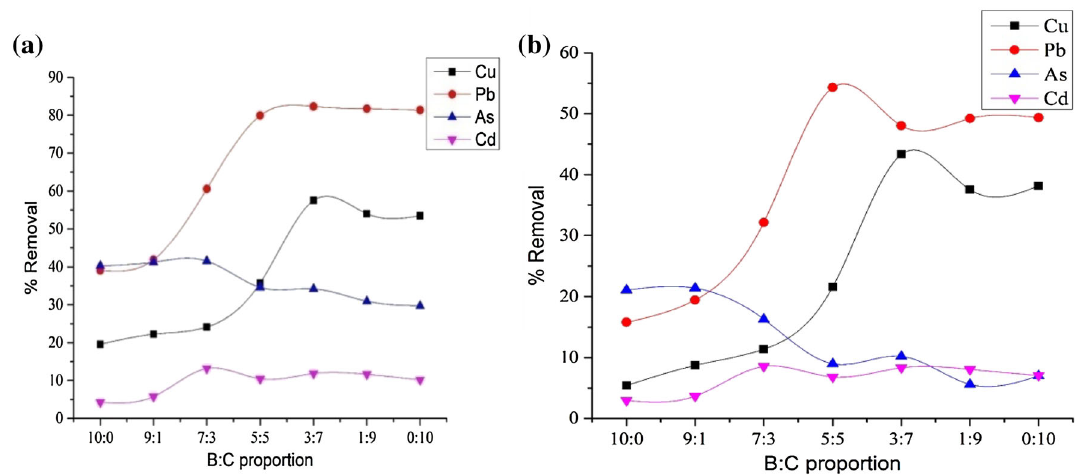
Fig. 5 Comparison of heavy metals removal (%) from a synthetic solutions, b industrial